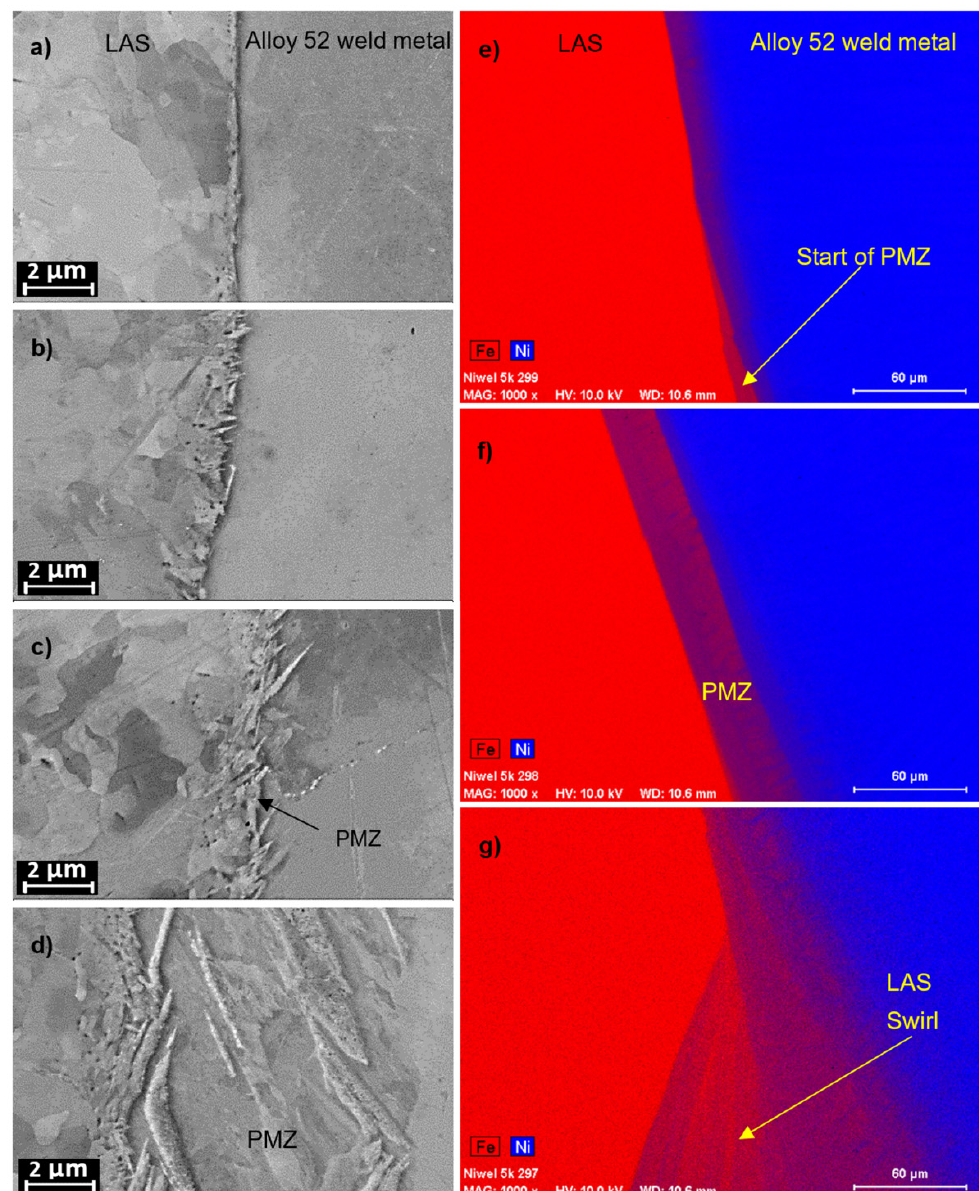
Figure 7. SEM imaging of the growth of the partially-melted zone (PMZ) layer from ( a ) a straight fusion line to ( d ) a rather large (about 10 μ m) PMZ, and EDS maps showing the increase in iron dilution into the weld metal from ( e ) the start of PMZ to ( g ) a LAS swirl. The beginning of the weld pass increases the width of the PMZ and the dilution of iron (red) from the LAS to the nickel-rich (blue) weld metal.